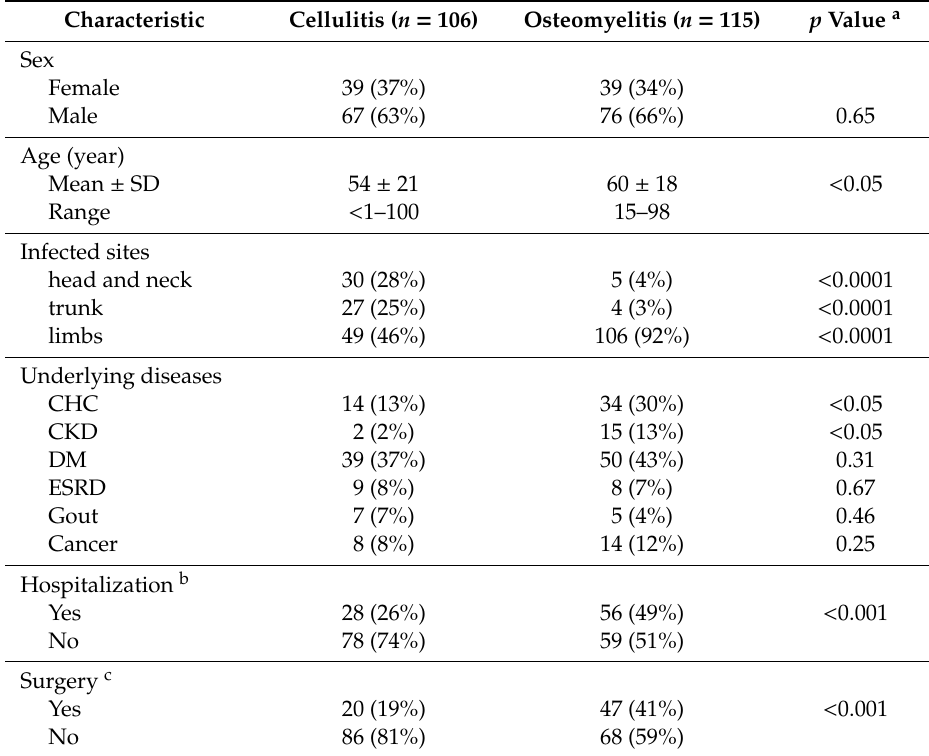
Table 1. Basic demographics of patients with MRSA